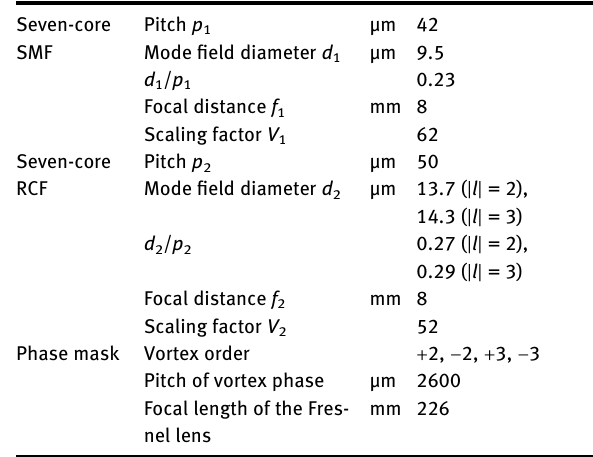
Table  : Experimental parameters of the ‘  -to-  ’ coupling